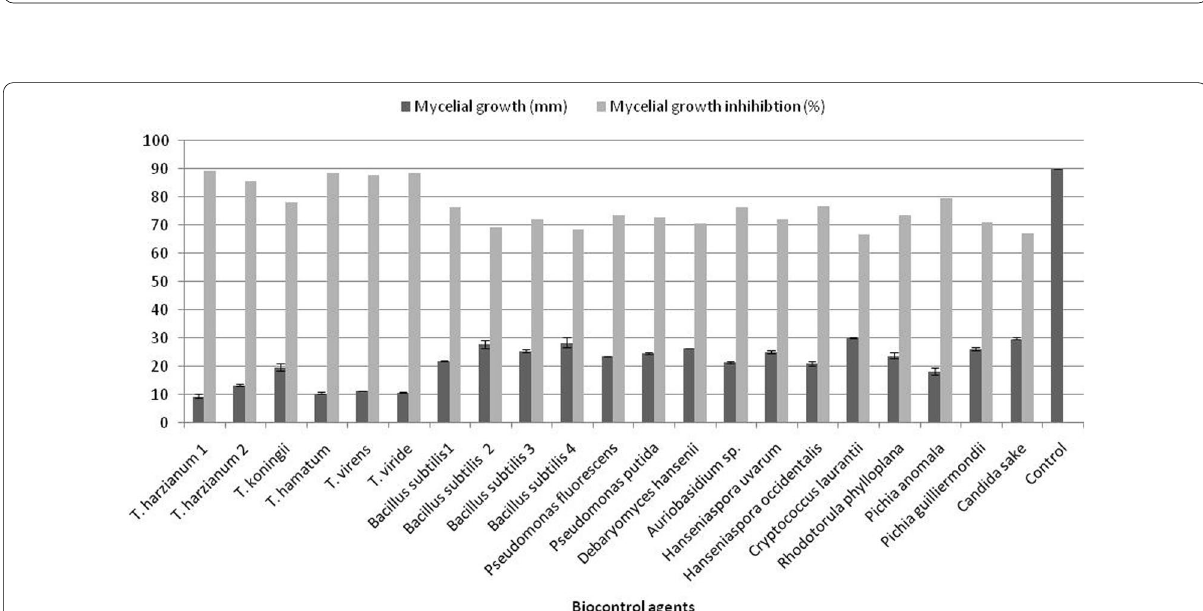
Fig. 1 Phylogenetic tree based on the ITS sequences showing the relationship between sequences of different Colletotrichum spp. and similar other sequences deposited in the NCBI GenBank, USA